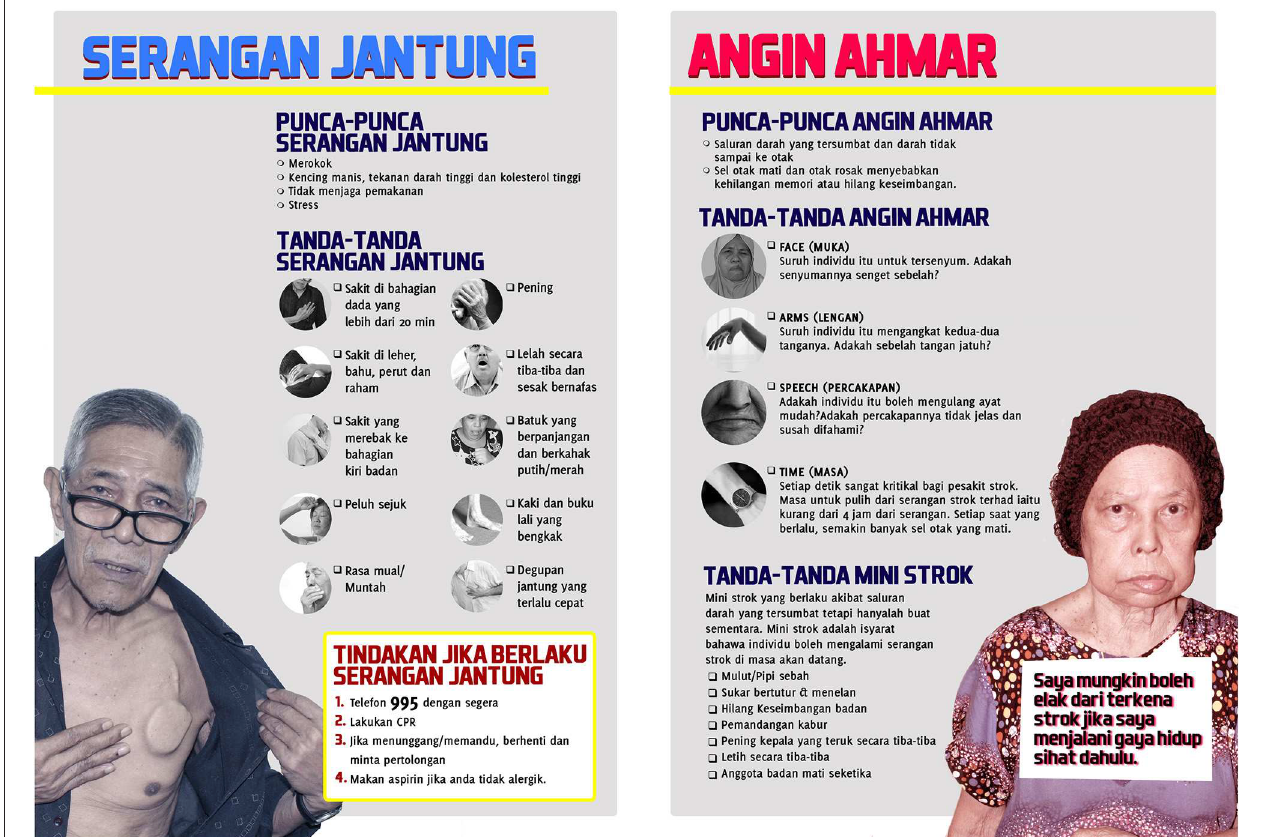
FIGURE 1 | Symptoms of a Heart Attack &